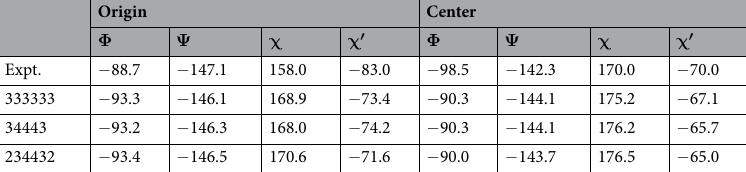
Table 2. I β cellulose torsion angles (degrees) in 6 × 3, 234432 and 34443 models. Φ : O5C1O4C4, Ψ : C1O4C4C5, χ : O5C5C6O6, χ′ : C4C5C6O6. Experiment values are from refs 1,2 .